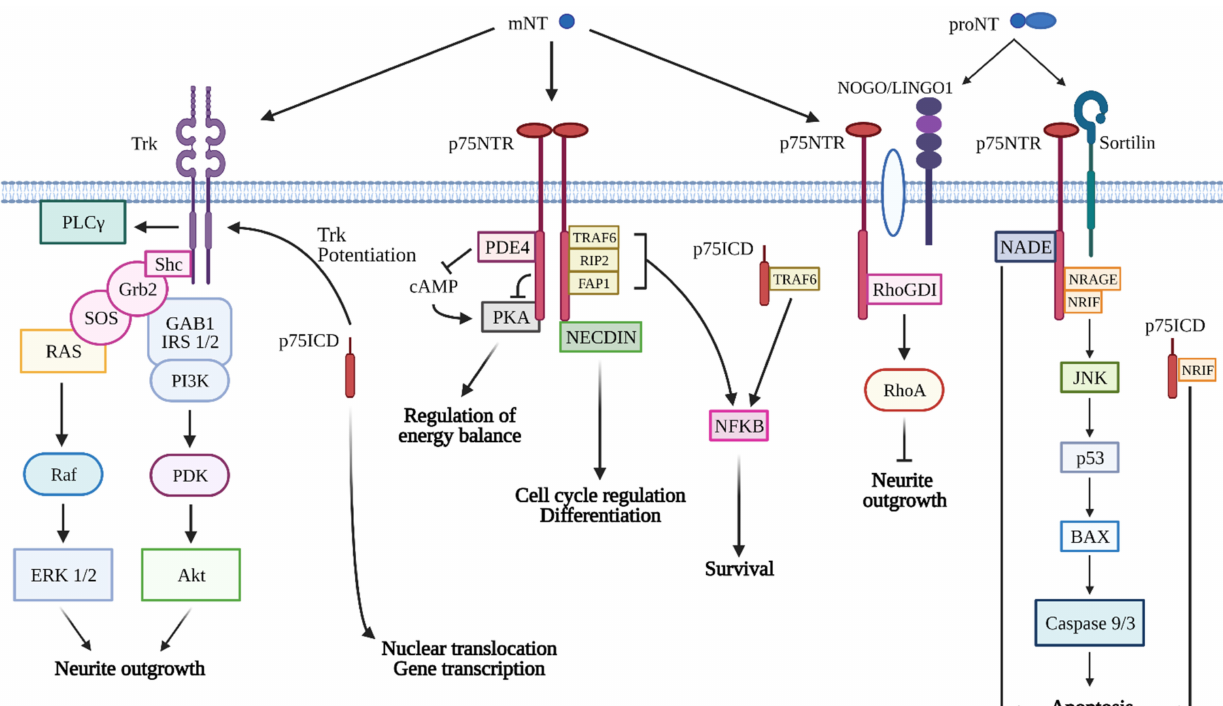
Figure 1. Signaling pathways mediated by neurotrophins’ binding to their receptors. Neurotrophins bind to two main receptor types: Trk receptors and p75NTR. Pro-neurotrophins (proNT) processing generates mature neurotrophins (mNT). Upon mNT stimulation, Trk receptors undergo autophosphorylation events, and recruit adaptor proteins